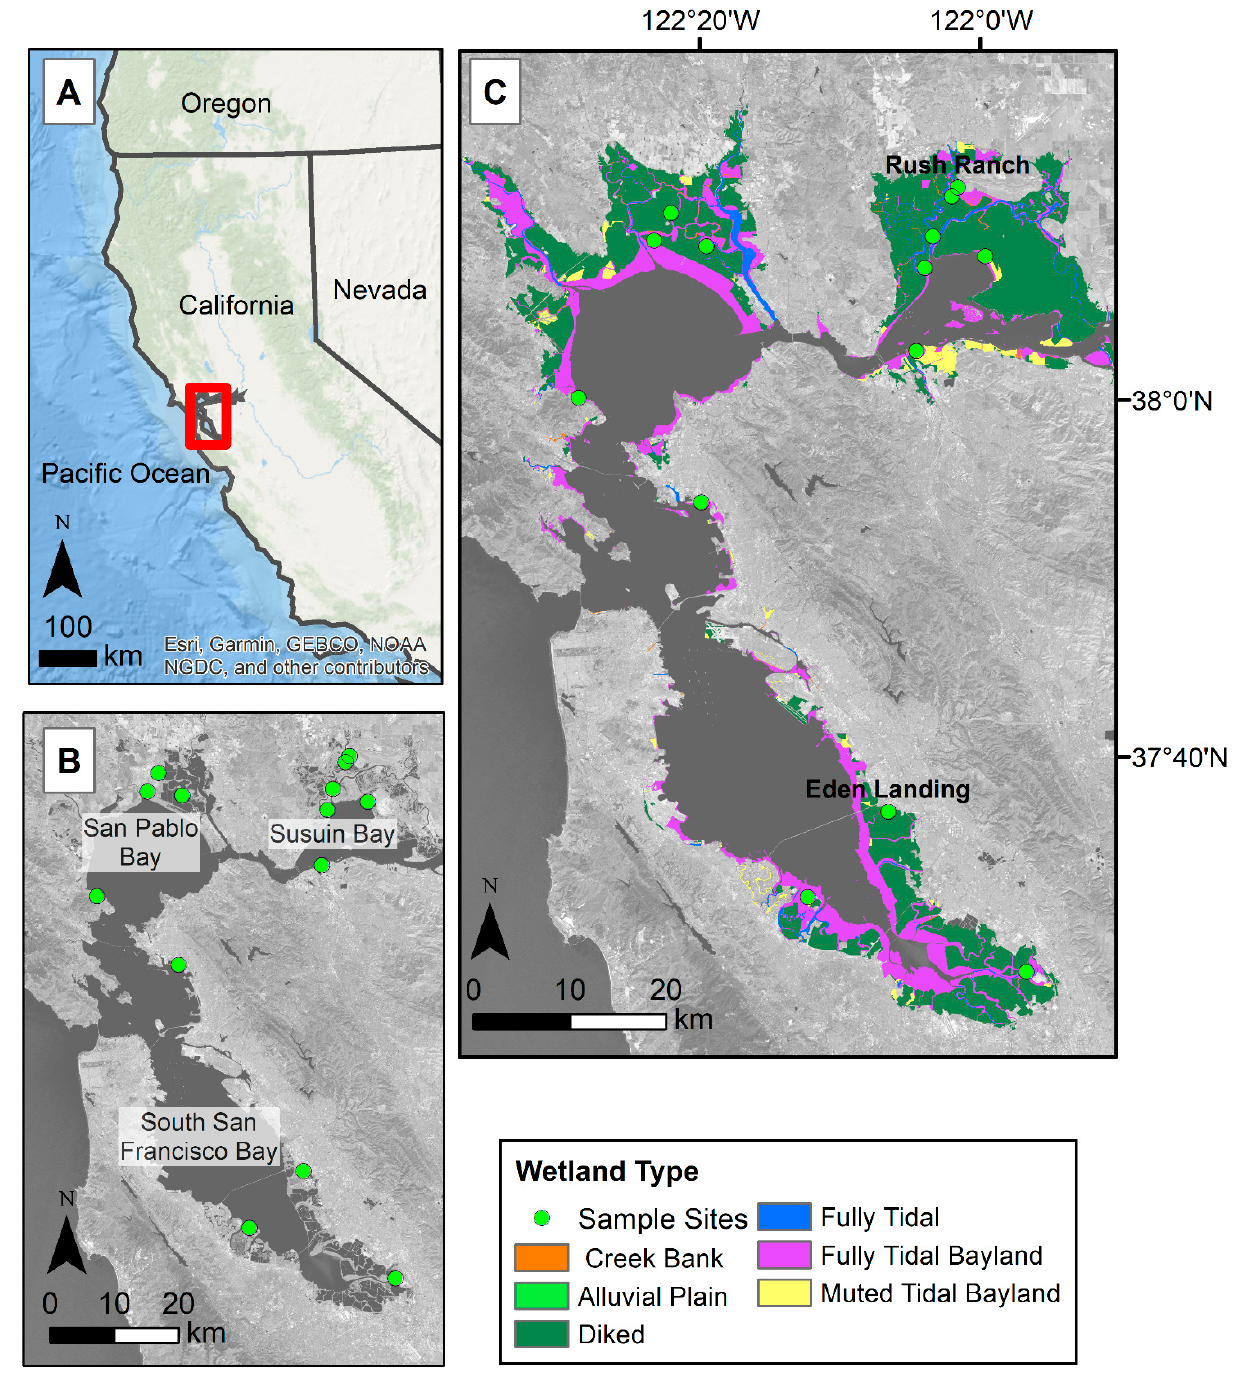
Figure 1. Site map of larger study area and locations used for model development. ( A ) Red box indicates study area in relation to California, USA. ( B ) Areas with green dots show the locations used for model development. ( C ) Colored areas indicate the overall study area, and the different colors break up the wetlands by type as defined by the San Francisco Bay Area EcoAtlas Modern Baylands type [33]. Eden Landing and Rush Ranch sites shown in panel C are wetland sites with eddy covariance stations measuring greenhouse gas fluxes. Basemap images in panel B and C are Landsat 8 band 7 (SWIR 2), U.S. Geological Survey.